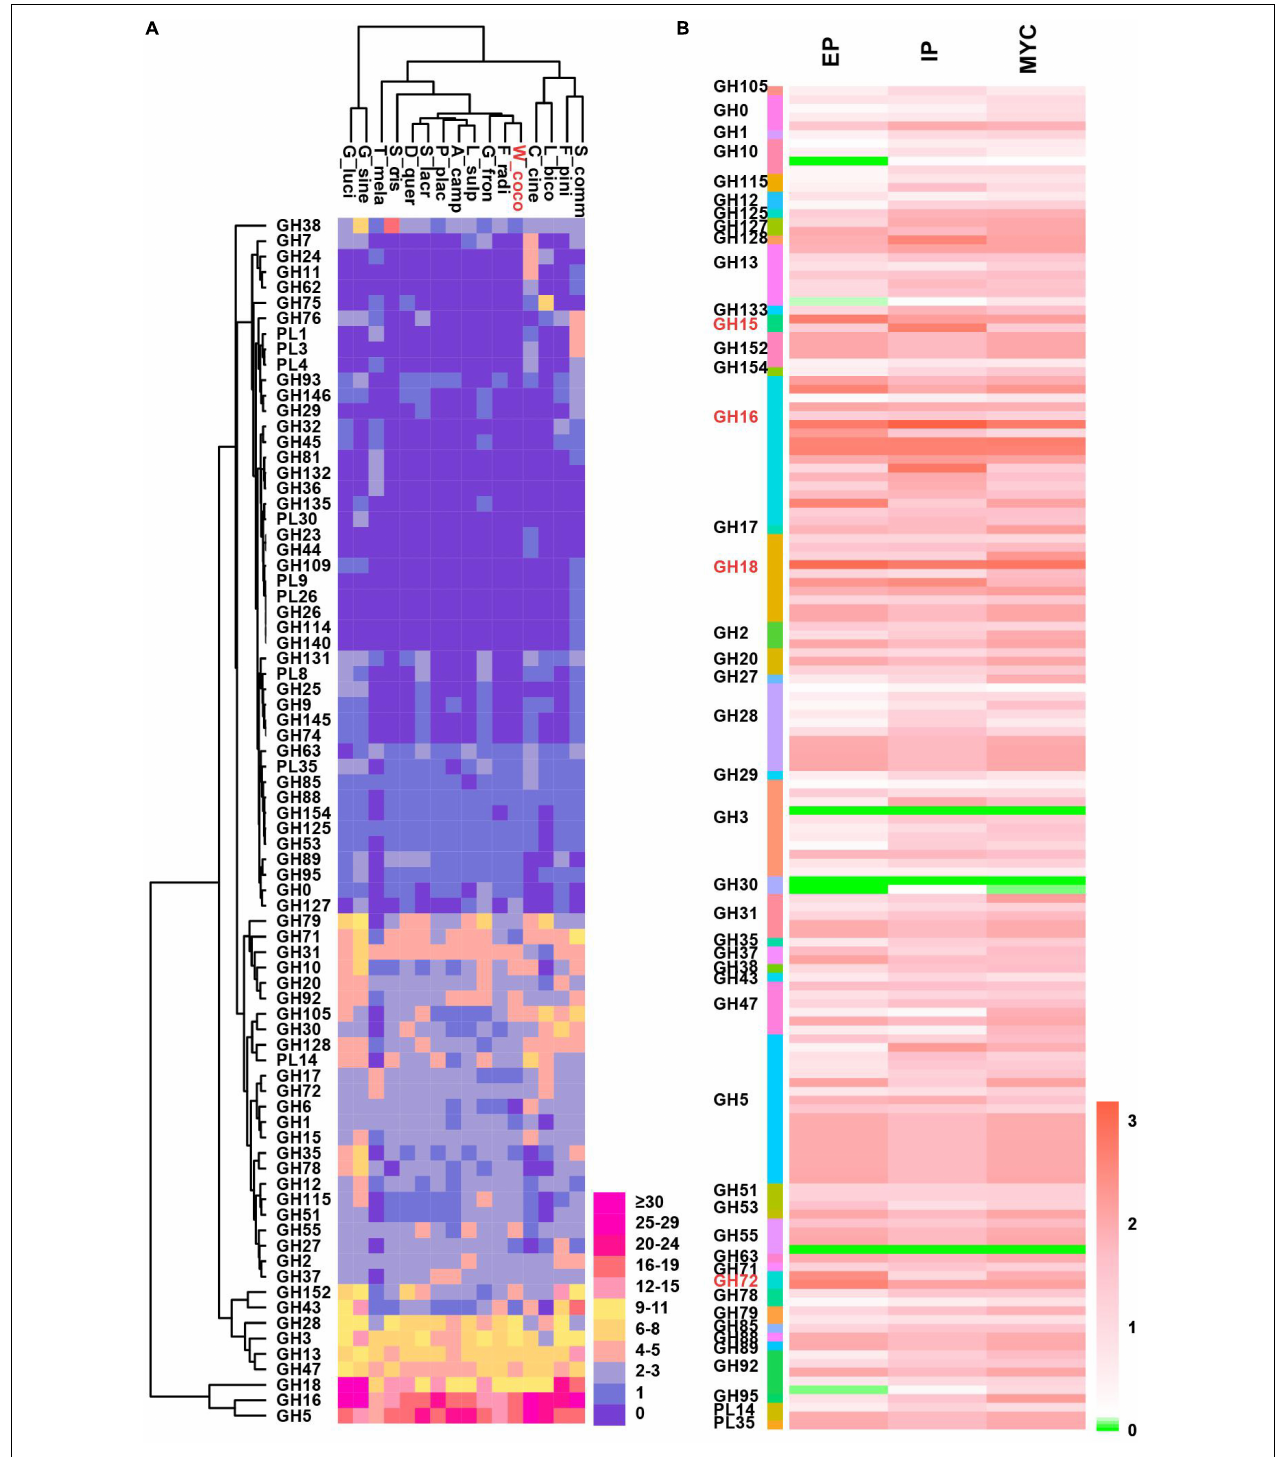
FIGURE 4 | The double clustering glycoside hydrolase (GH) and polysaccharide lyase (PL) families of CAZymes from representative wood-rot fungi genomes and the CAZymes expression level in WCLT. (A) The depicted double cluster of GH and PL families in representative wood-rot fungi genomes. The fungi named are Schizophyllum commune (S_comm), Fomitopsis pinicola (F_pini), Laccaria bicolor (L_bico), Coprinus cinereus (C_cine), Wolfiporia cocos (W_cocos), Fibroporia radiculosa (F_radi), Grifola frondosa (G_fron), Laetiporus sulphureus (L_sulp), Antrodia camphorata (A_camp), Postia placenta (P_plac), Serpula lacrymans (S_lacr), Daedalea quercina (D_quer), Sparassis crispa (S_cris), Tuber melanosporum (T_mela), Ganoderma sinense (G_sine), and Ganoderma lucidum (G_luci) from right to left. Abundance of the different enzymes within a family is represented by a color scale from 0 (blue) to 30 occurrences (red) per species. (B) GH and PL family gene expression in the WCLT